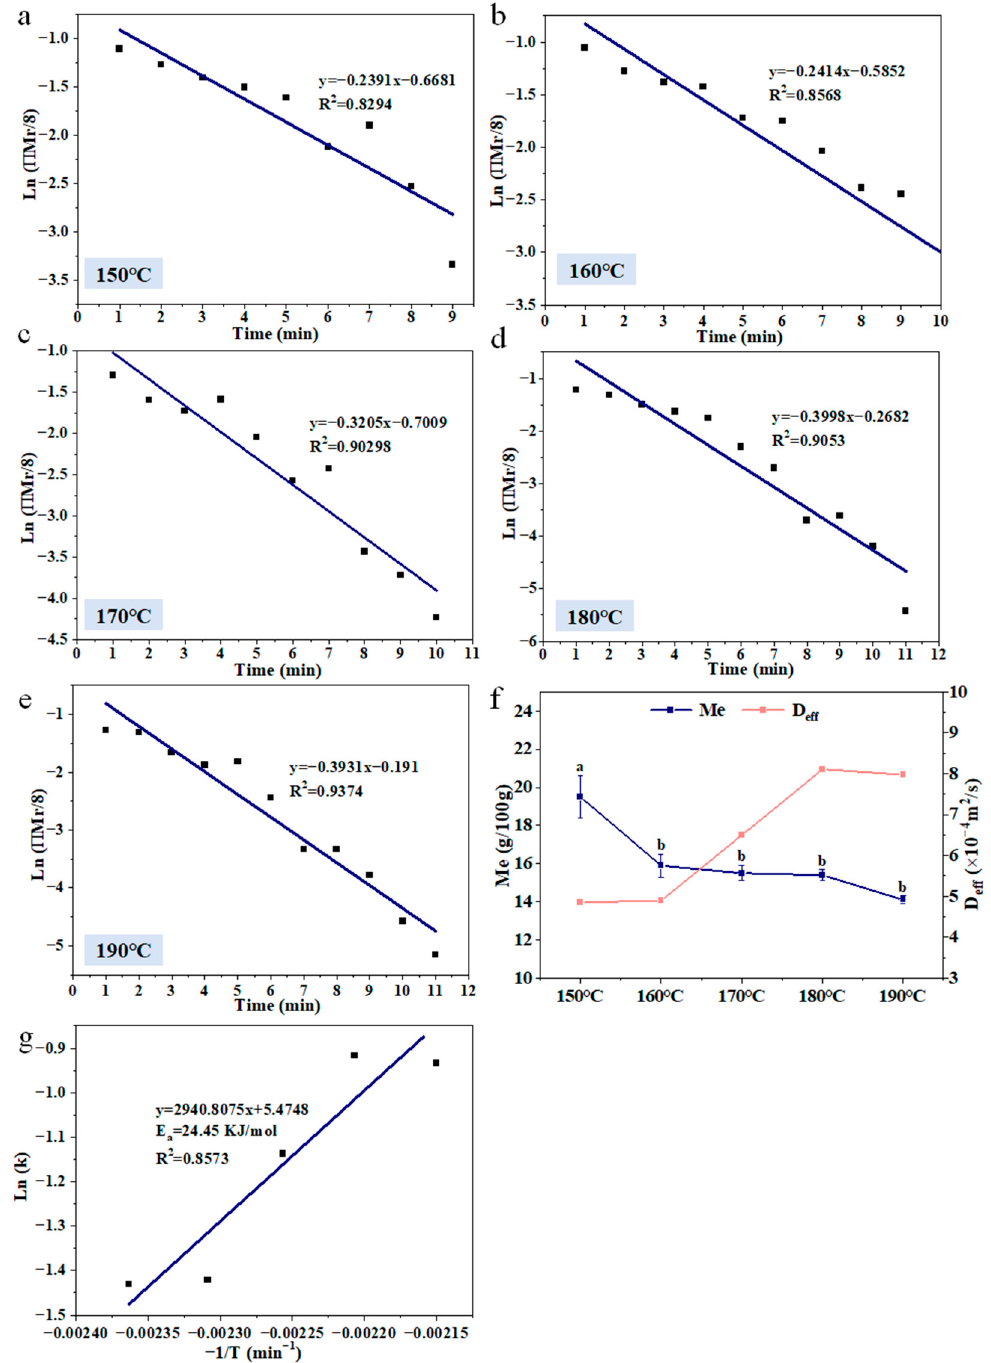
Figure 3. The modeling of water loss kinetics ( a – e ), kinetic parameters ( f ), and activation energy of water loss ( g ) in French fries. The results are the mean ± SE. Different letters (a,b) indicate significant differences ( p ≤ 0.05).